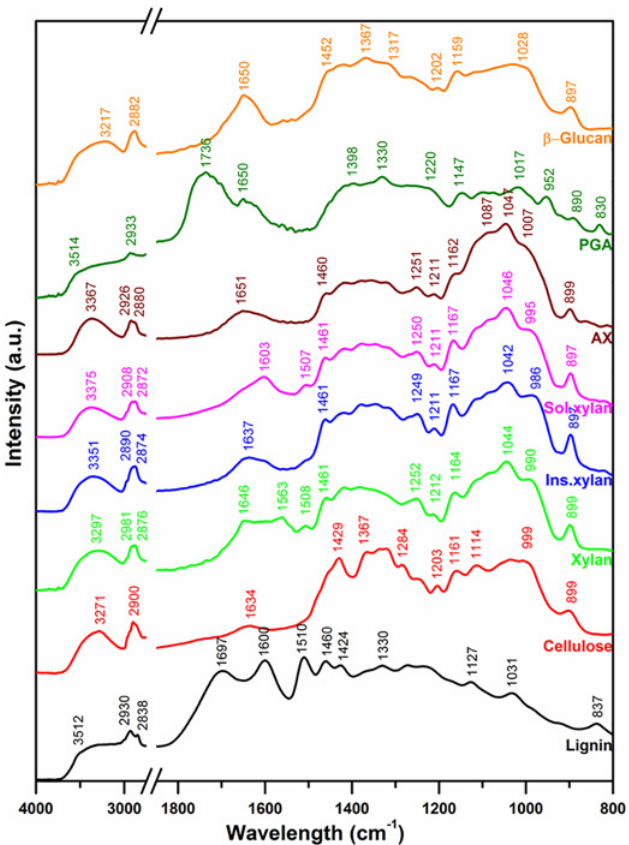
Fig 3. FT-IR photo acoustic spectra of lignin, cellulose, xylan, arabinoxylan, polygalacturonic acid, and β